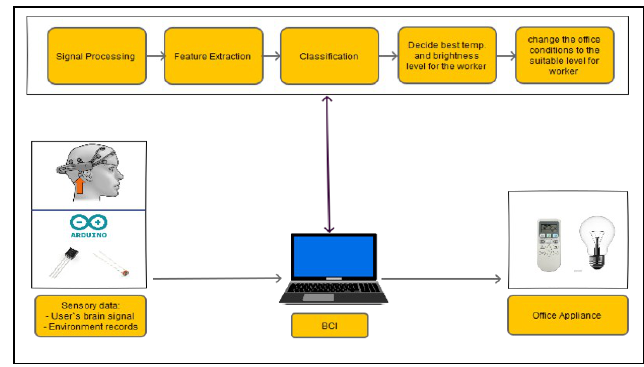
Figure 3. Basic structure of the proposed smart office